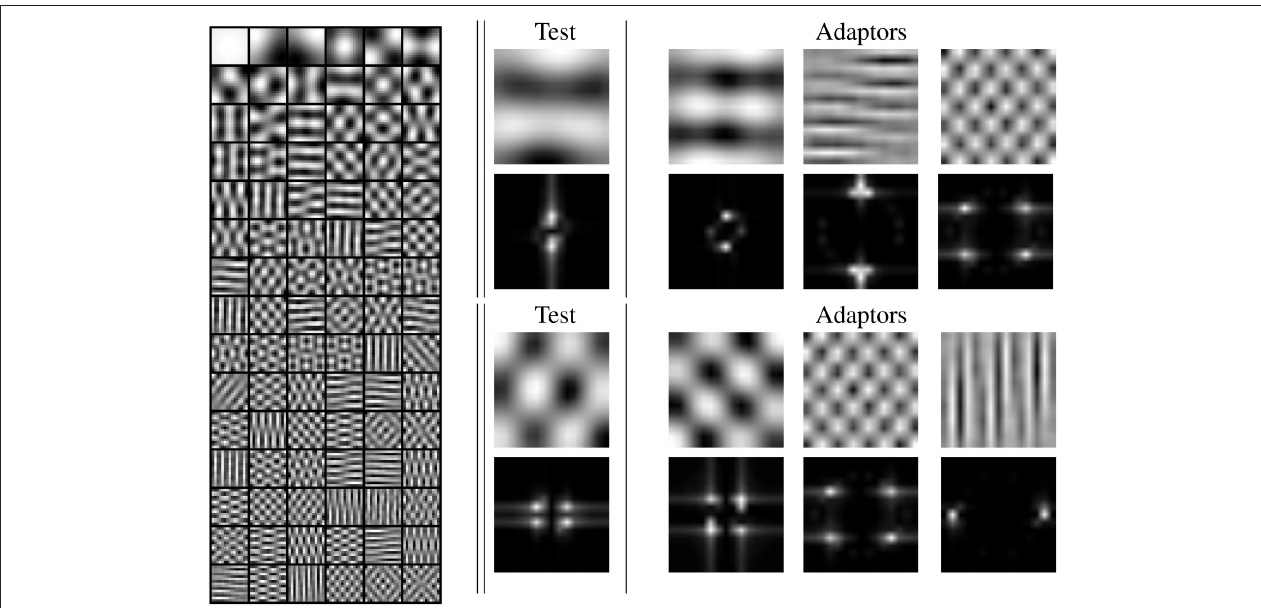
FIGURE 6 | Left linear receptive fields from natural textures using PCA. Center test stimuli (or selected filters) in the spatial domain (oscillatory patterns) and in the frequency domain (narrow band light regions on dark background). Right stimuli to set different adaptation environments (adaptors) for the test on the center panel. The Fourier transforms show the frequency similarity between tests and adaptors .